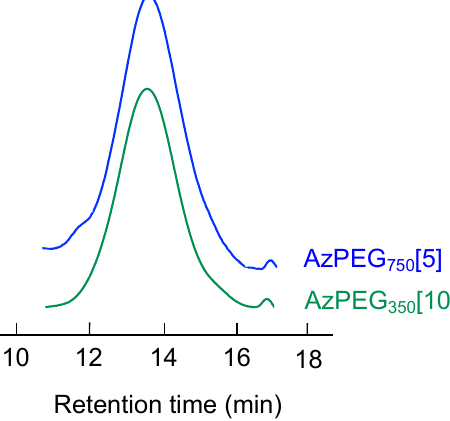
Figure 3. GPC charts of AzPEG350 [10] (green) and AzPEG750 [5] (blue), proving that the azidophenyl group was successfully synthesized via the copolymerization of AzPheEO with EO and mPEG-EPO. Eluent: DMF containing 10 mmol/L LiBr. Flow rate (1 mL/min).